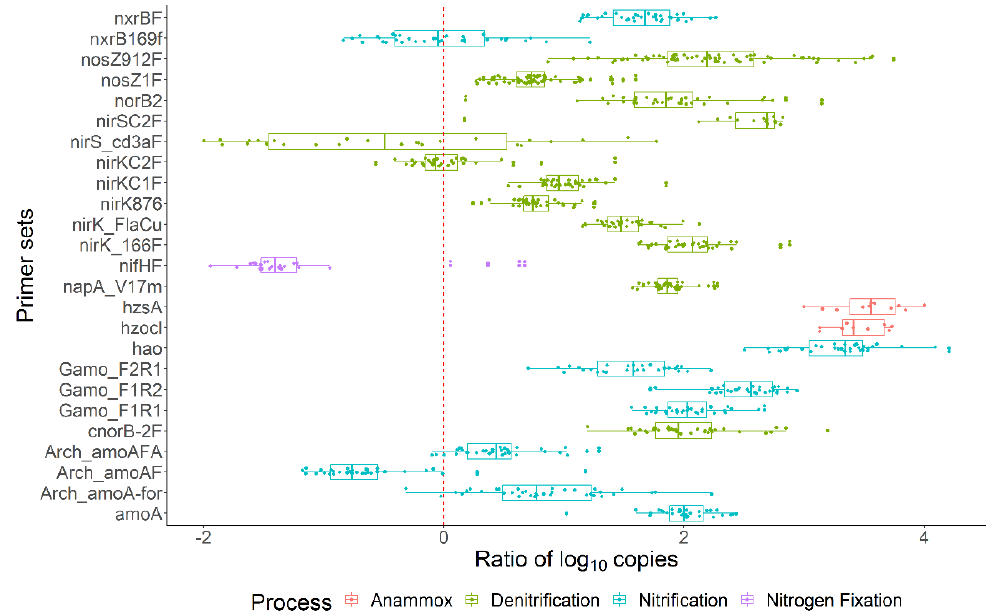
Figure 5. N cycle gene expression using ratios of log 10 gene copies and transcript quantities. The processes include anammox, denitrification, nitrification, and nitrogen fixation.